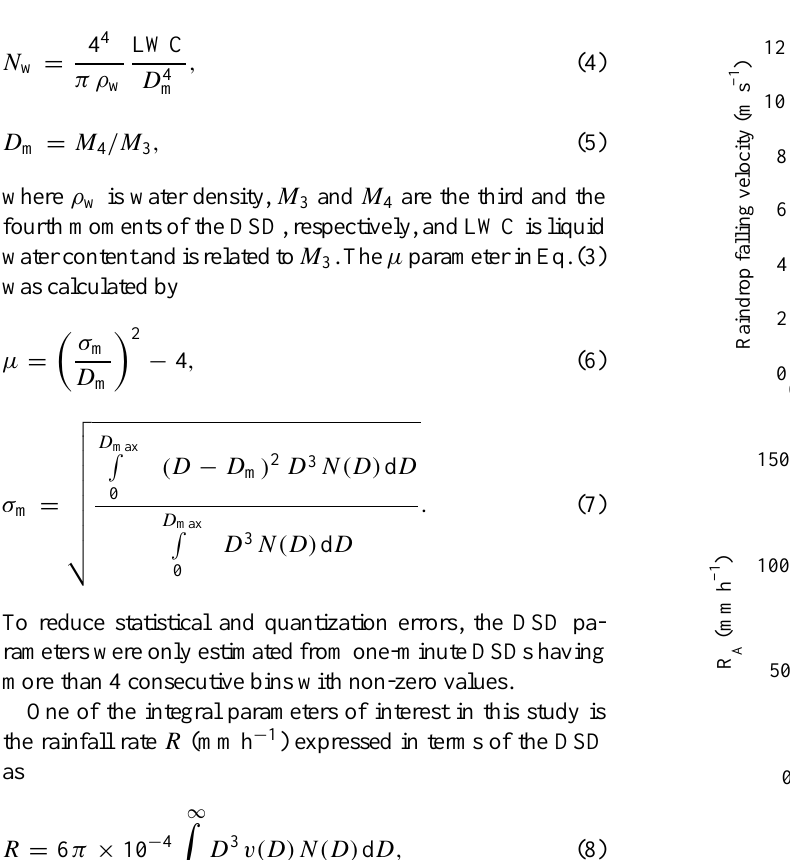
Fig. 2. (a) Raindrop falling velocity versus raindrop diameter for rain events at KT during January 2012. The frequency of occurrence is contoured on a log (number) gray scale. The mean ( + ) and the empirical velocity of Atlas et al. (1973) indicated by black line are also given. (b) Scatterplot of rainfall rate calculated by measured ( R m ) and empirical fall velocity ( R A